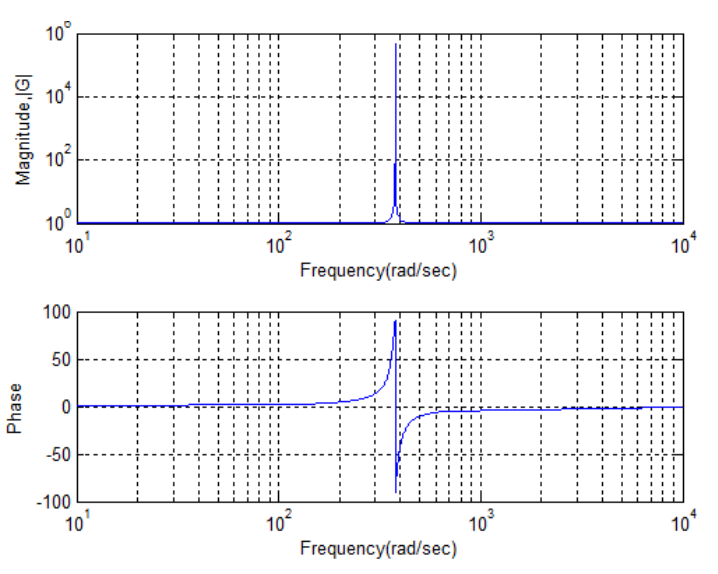
= 1, K = 20, ω = 377 rad/s, and ω p i